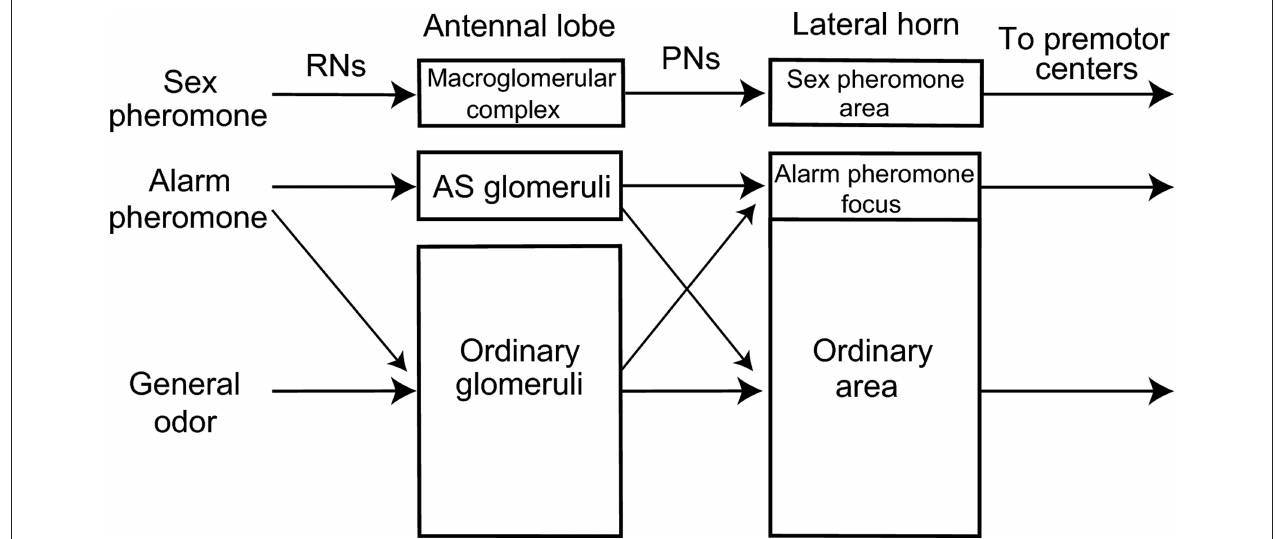
cockroaches, honeybees and fruit-flies. There is segregated, yet partially overlapped, representation of alarm pheromone information in the